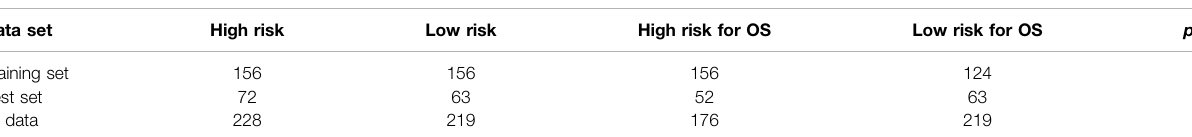
TABLE 4 | Survival analysis sample.